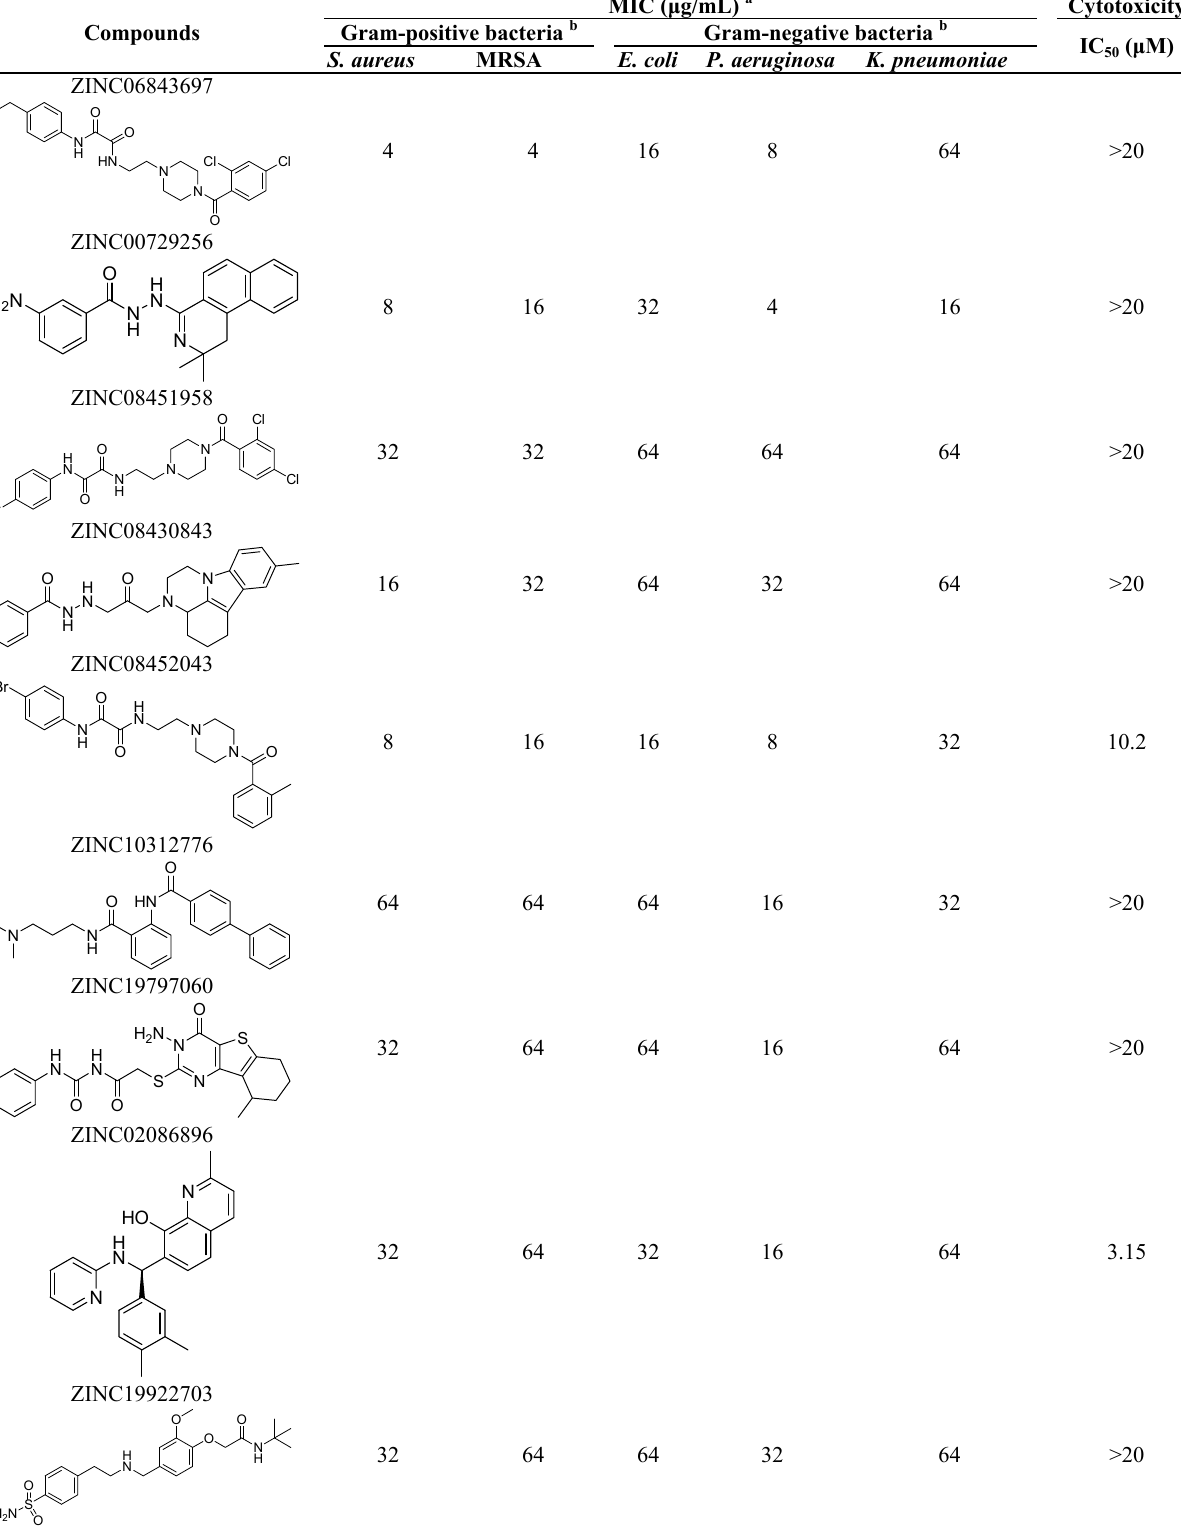
Table 2. In vitro antibacterial activity and cytotoxicity of final hit compounds.